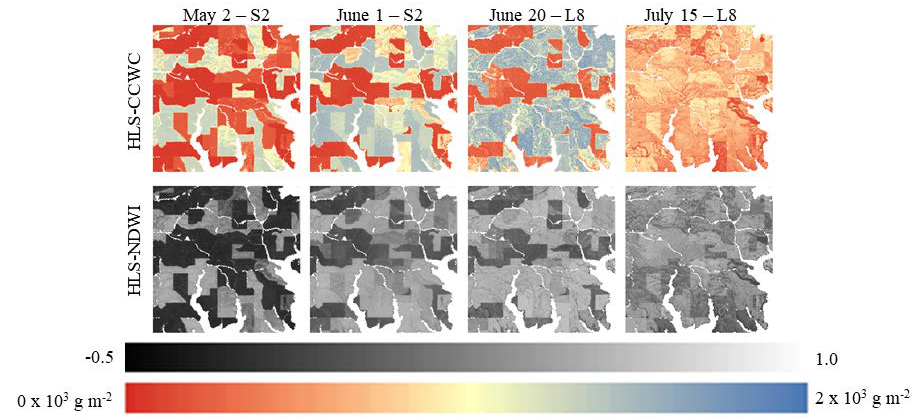
Figure 10. Comparisons of strategy 3 CCWC product (top) for each labeled date and sensor (S2 and L8 for Sentinel-2 and Landsat-8, respectively) with the coincident normalized difference water index (NDWI) derived image (bottom) for the 8 km x 8 km study area.